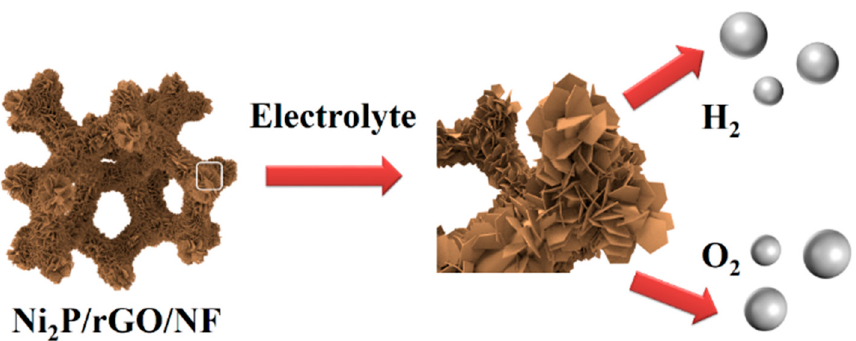
Figure 1. Map of overall water splitting in Ni 2 P/rGO/NF electrode.